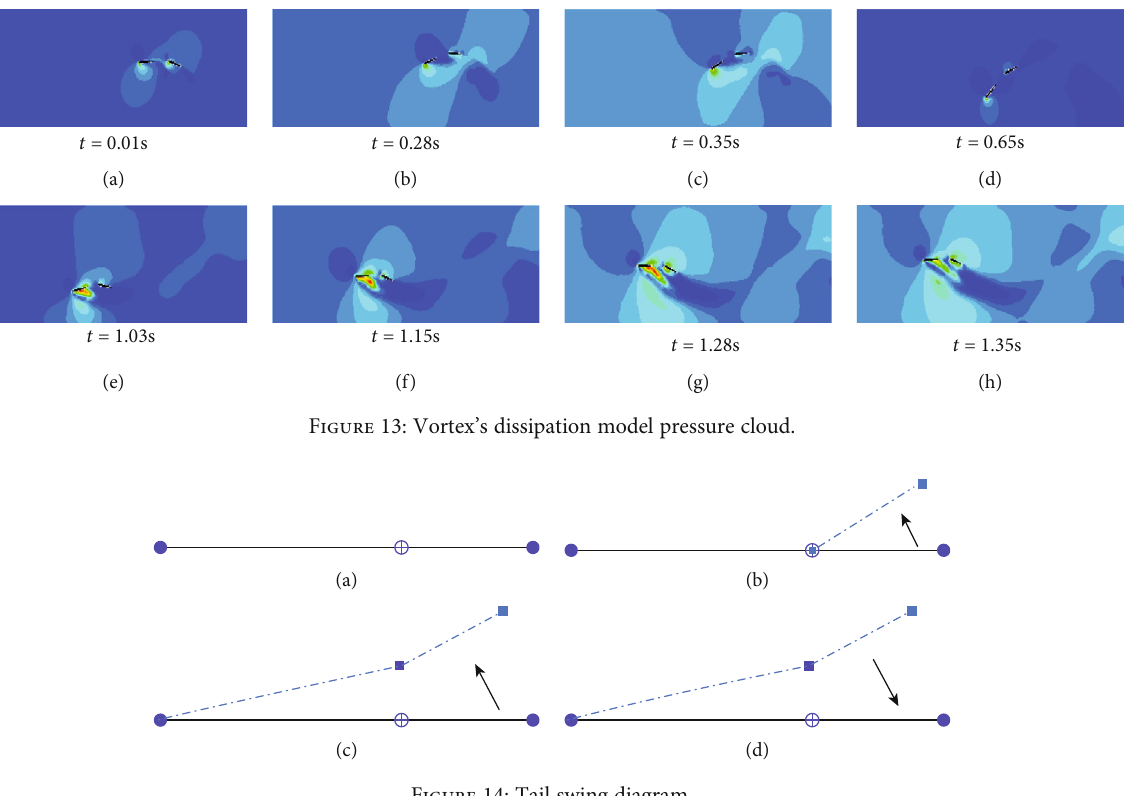
Figure 14: Tail swing diagram.